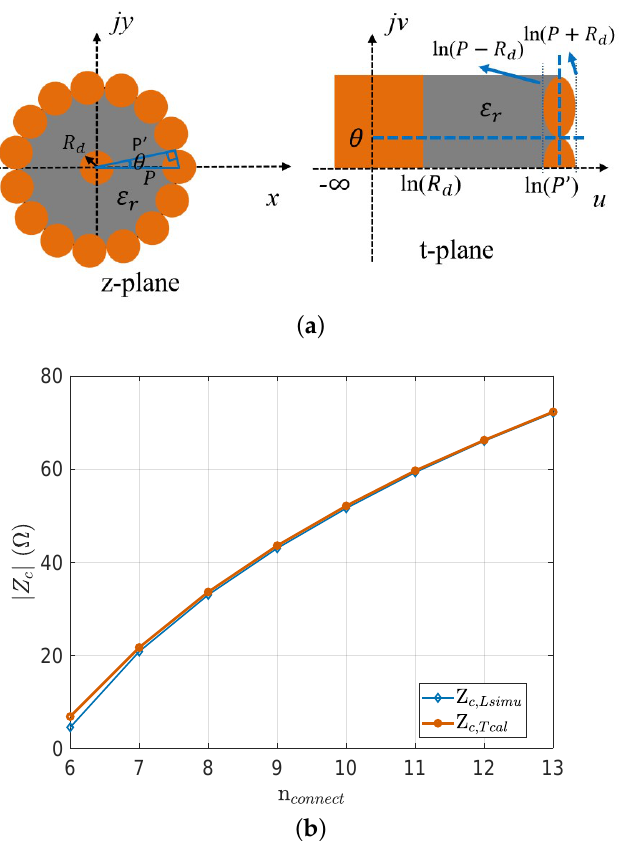
Figure 5. ( a ) Schematics of the coaxial-like TSV in the z − plane and the transformed t − plane with TSV- based outside ground conductor. ( b ) Comparison between simulated and calculated characteristic impedance of connected-TSV-based coaxial-like TSVs, with the connected TSV number ranging from 6 to